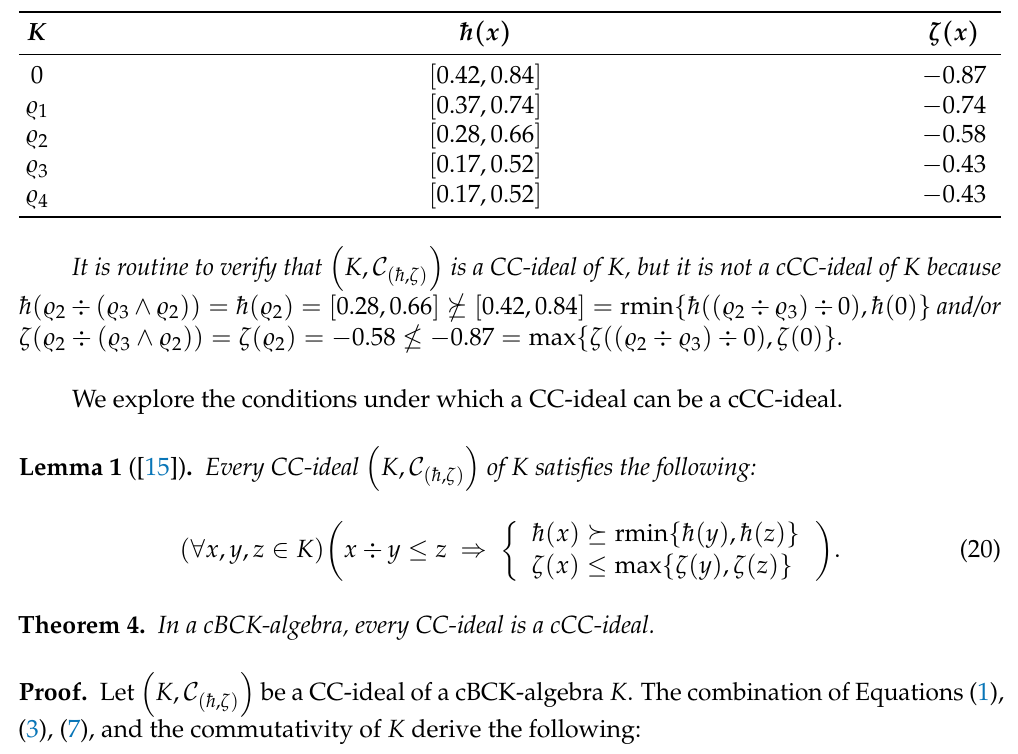
(cid:16) (cid:17) K , C ( ¯ h , ζ )